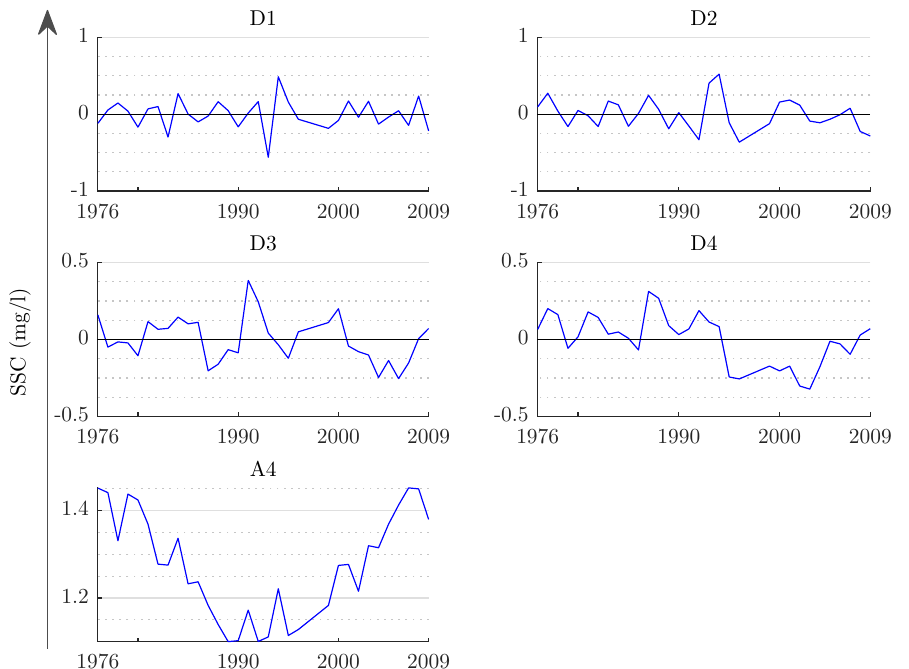
Figure 6. Detailed coefficients of (DW1) two years, (DW2) four years, (DW3) eight years, and (DW4) sixteen years along with the approximation coefficient (A4) of Partab are shown.